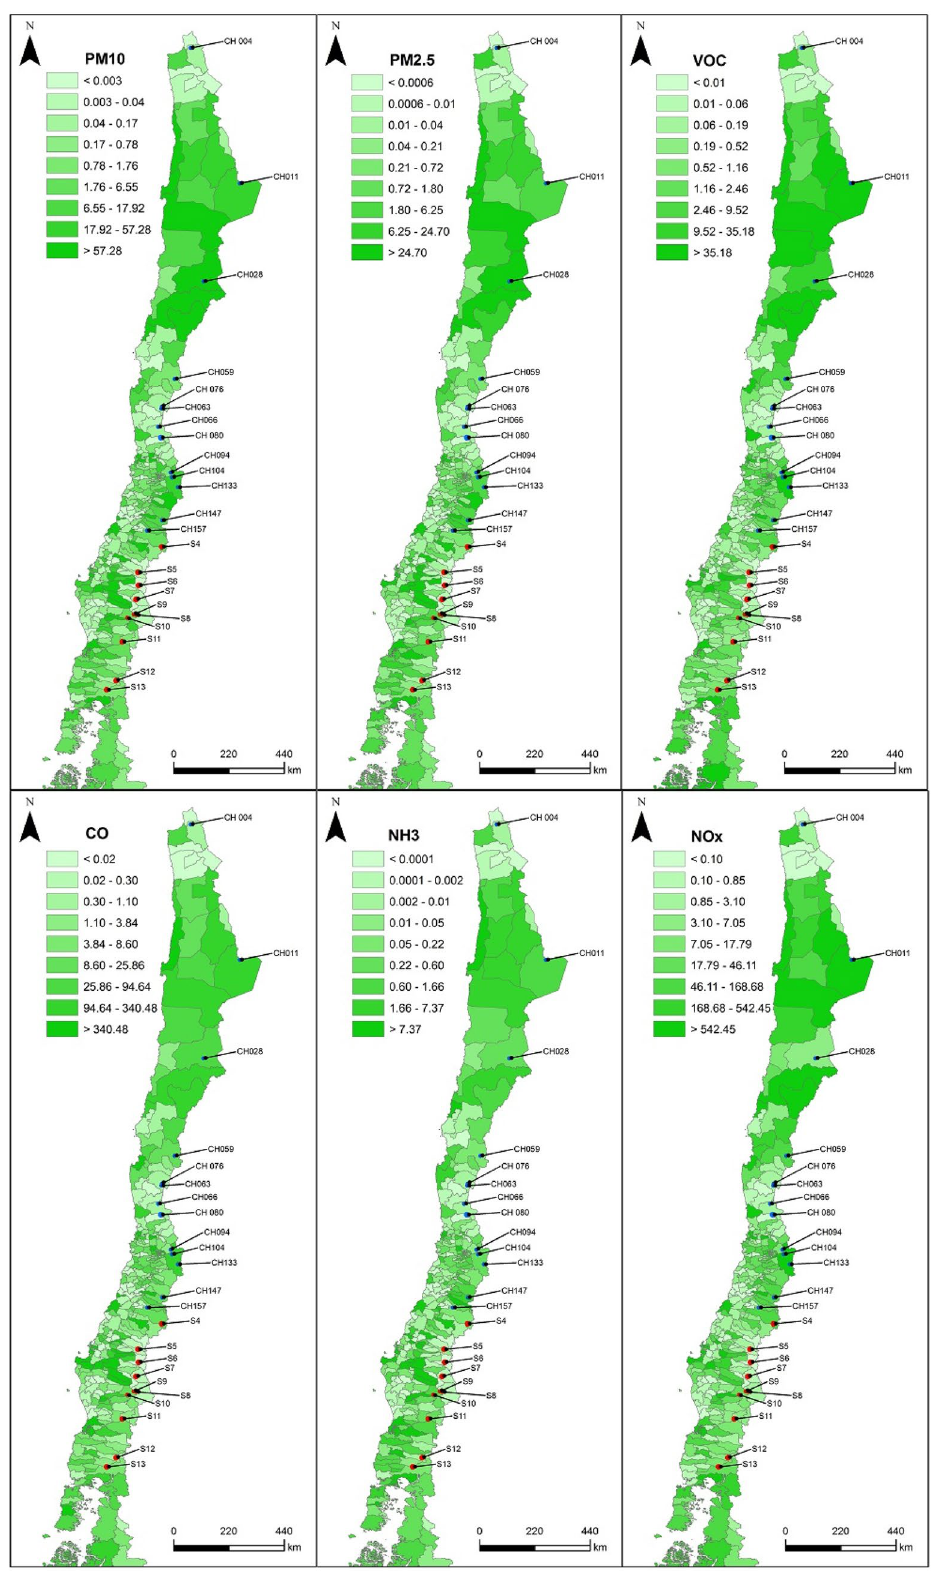
Figure 2. Map showing point source emissions (ton/year) of six different gaseous and particulate contaminants reported at the communal level during 2015 and 2016 35 . The code of sampling points is included as a reference. Maps were developed in ArcMap v.10.2.2 (http:// arcgis.